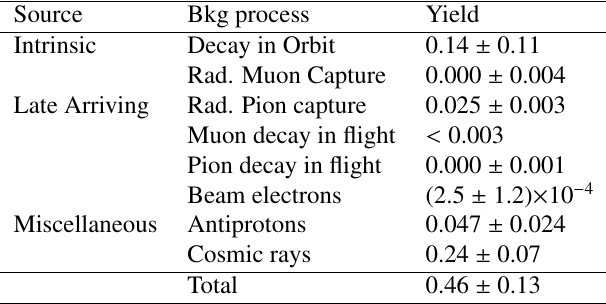
Table 1. Expected background list as evaluated by the full Mu2e simulation for a three years physics running at full